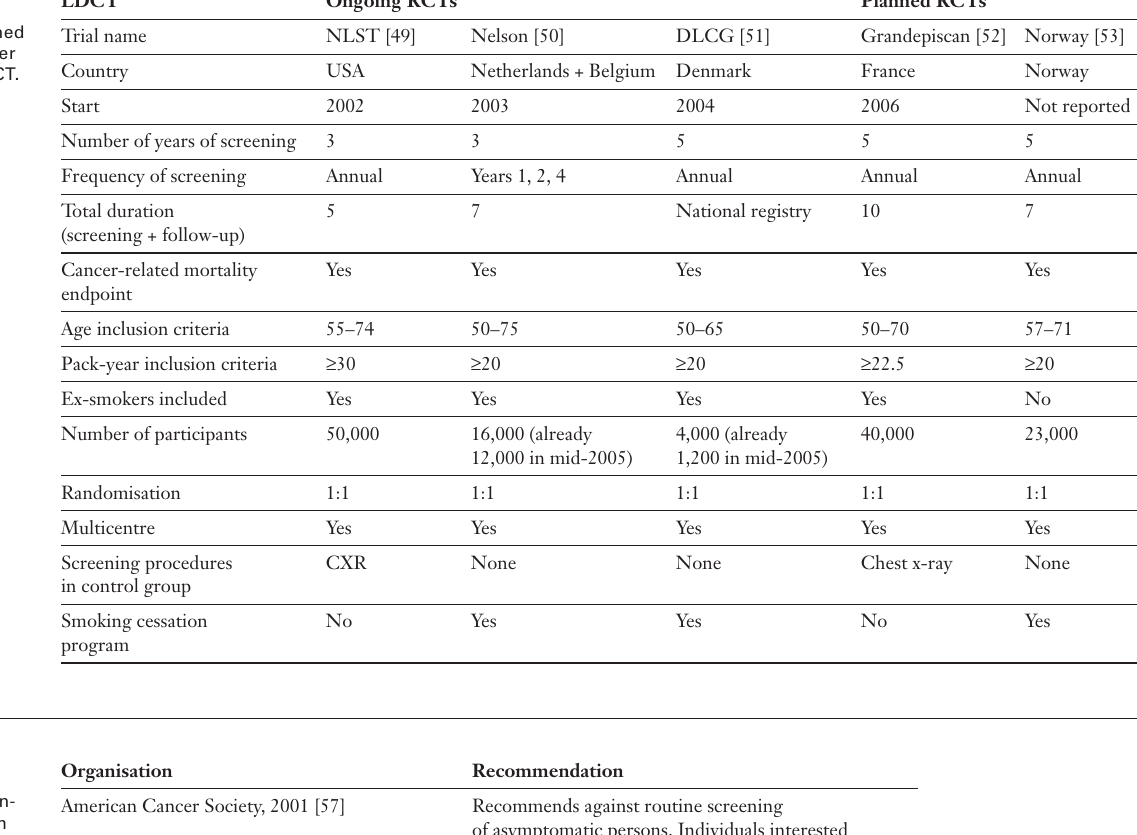
Ongoing and planned RCTs for lung cancer screening with LDCT.